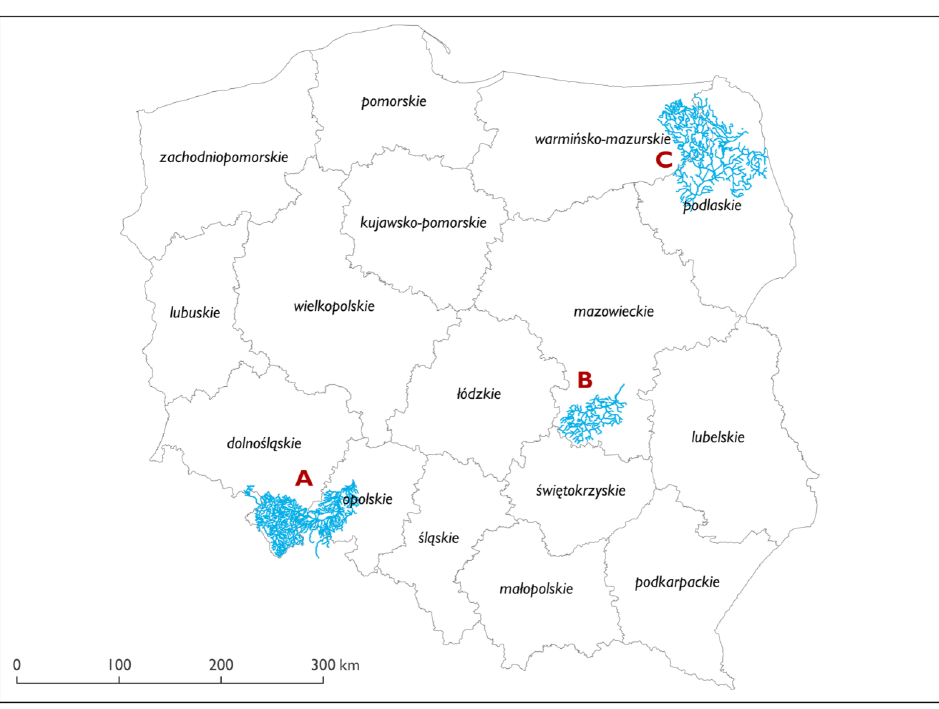
Fig. 2. Selected research areas in Poland, own elaboration. A – the Nysa Kłodzka